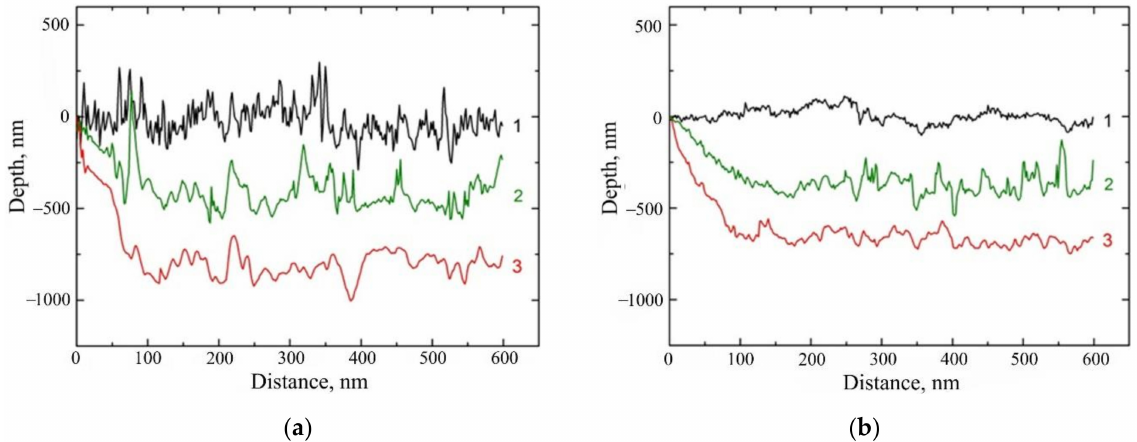
Figure 5. Longitudinal surface profiles of scratch grooves in the wrought ( a ) and EBAM ( b ) Ti-6Al-4V samples: 1—initial surface profile, 2—residual scratch profile, 3—scratch profile under loading.